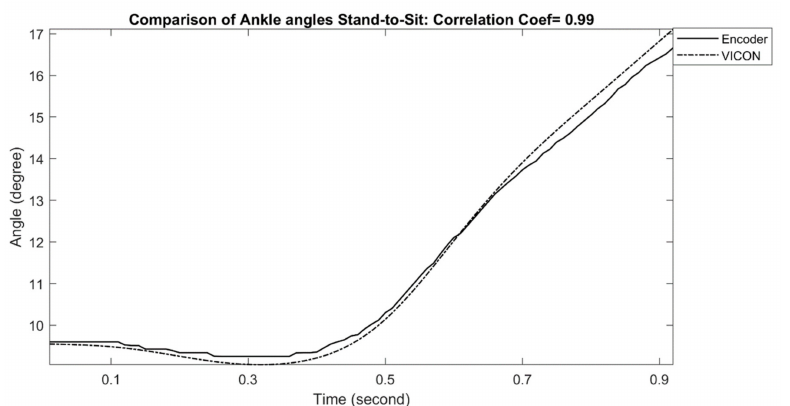
Figure 6. Comparison of Exo-skeleton’s ankle angle measurement with reference motion capture during stand to sit. In this data, the correlation coefficient was calculated at 0.99.